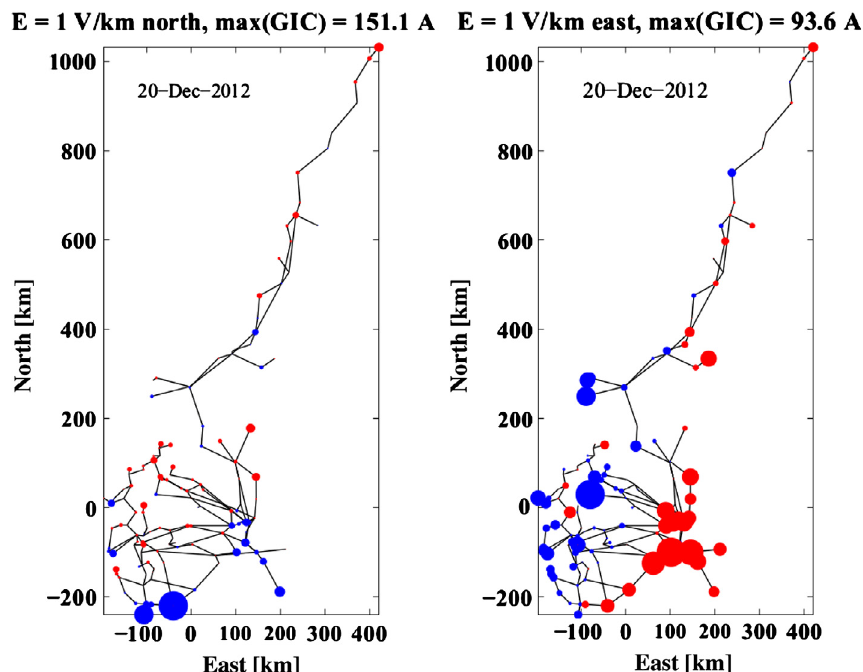
Fig. 3. GIC in the Norwegian high-voltage grid in 2012 due to a uniform electric field of 1 V km (cid:2) 1 to the north (left) or to the east (right). Blue means GIC from the ground into the grid and red is GIC from the grid into the